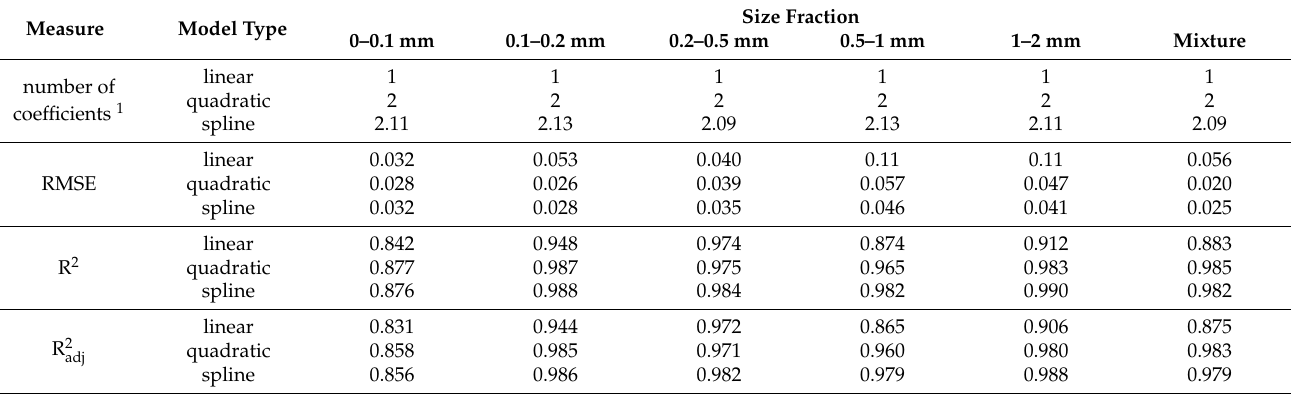
Table 1. Goodness of fit of estimated image intensity (output of proposed models) to true intensity (calculated from the images). Quality indices calculated according to Appendix B.